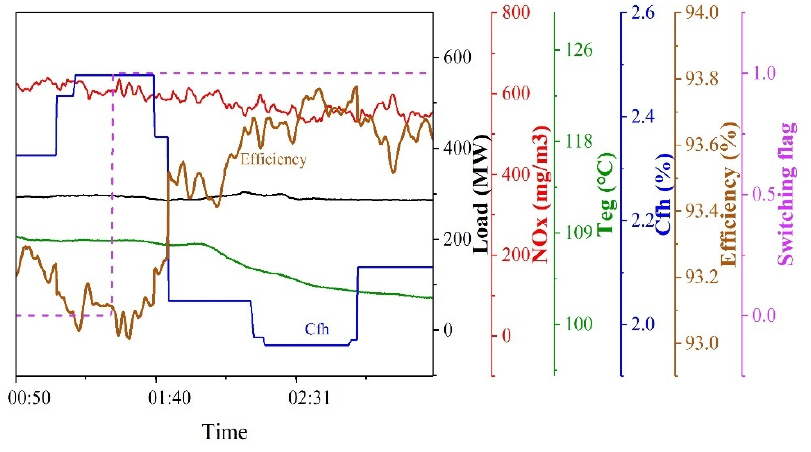
Figure 8. Results after combustion optimization.